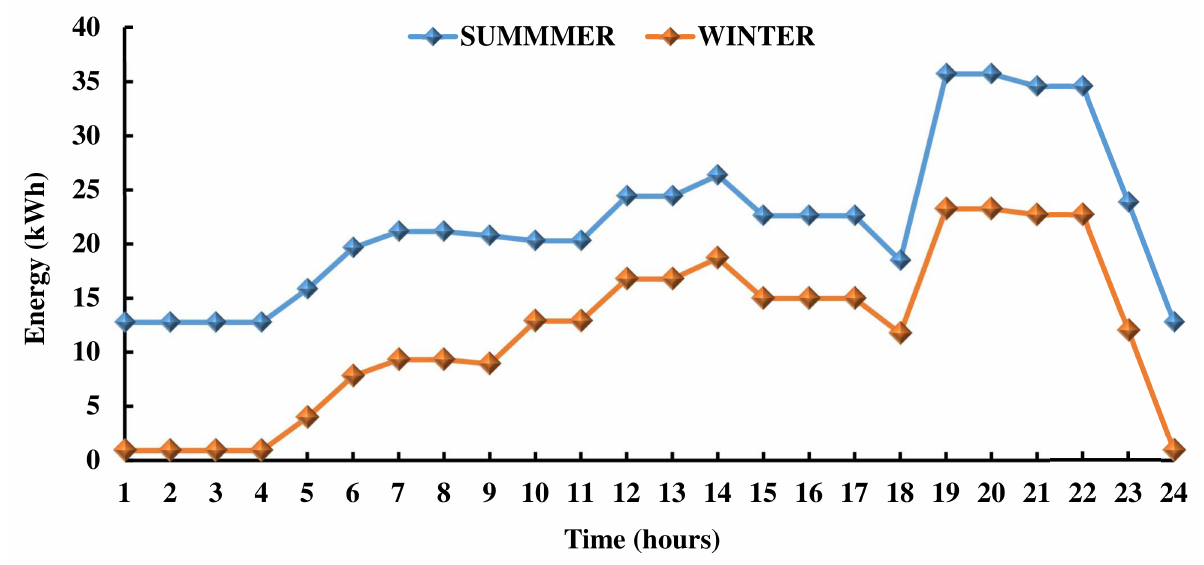
Figure 4. The daily load demand of the study